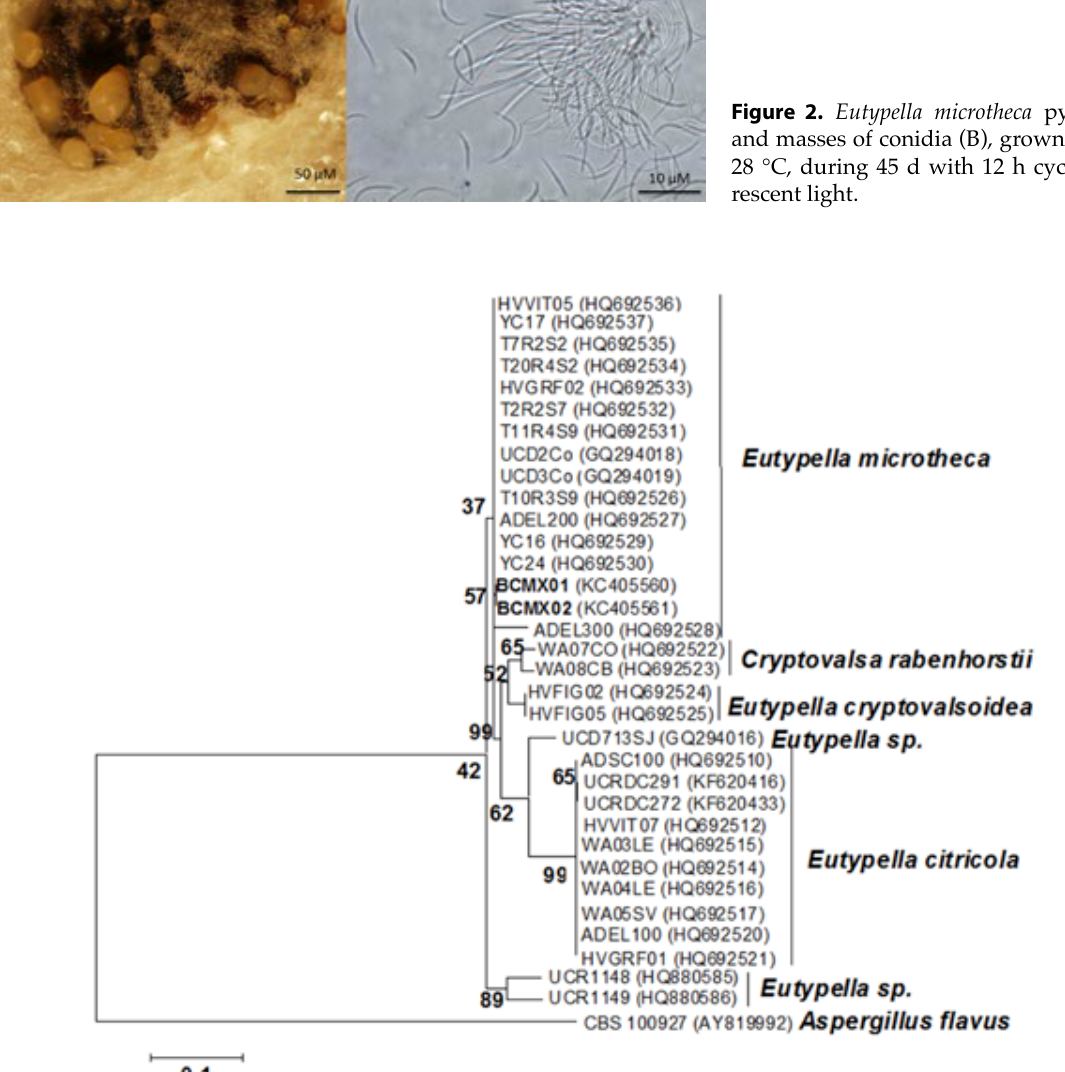
Figure 3 . Phylogenetic tree with the highest log likelihood (-1414.0028) obtained from the b-tubulin-ITS concatenated data- set. Bootstrap values from 1000 replicates are shown next to the branches. The tree is drawn to scale, with branch lengths measured in the number of substitutions per site. Species names are shown in bold and the accession numbers are shown between